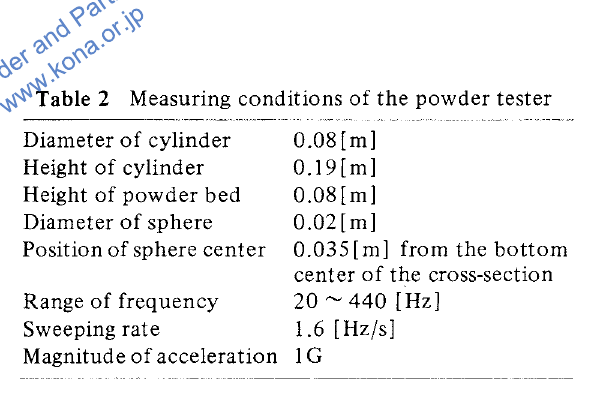
Table 2 Measuring conditions of the powder tester